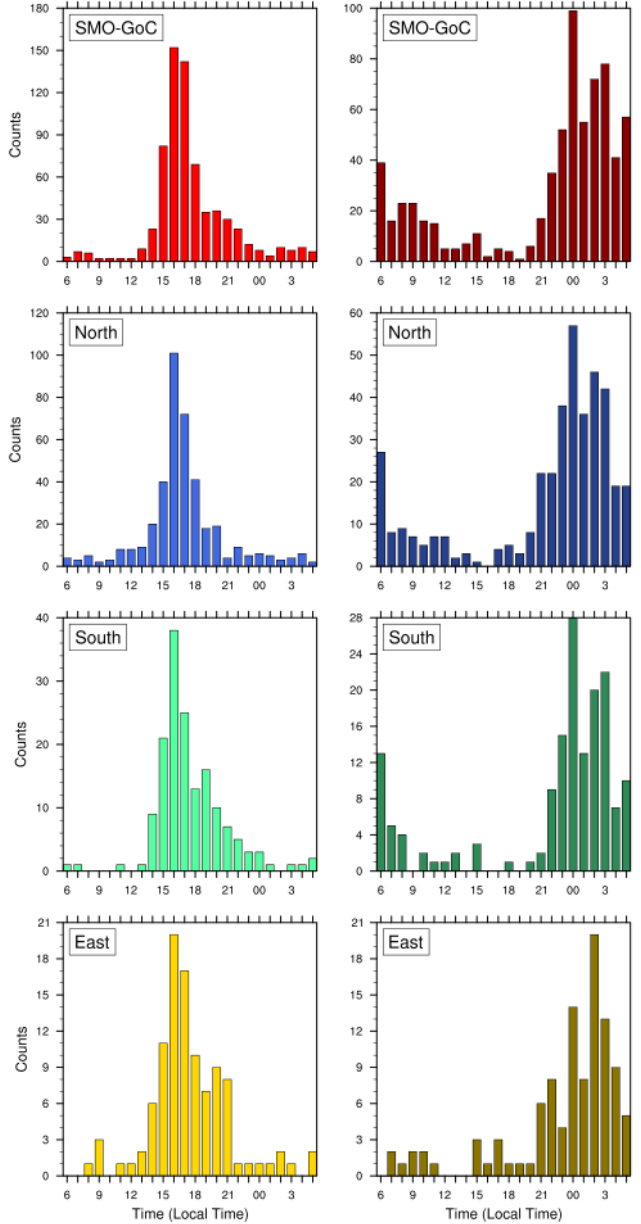
Figure 7. Diurnal cycle counts of MCS initialization time ( left column) and dissipation time ( right column) at LT (UTC-6). MCS propagating towards the GoC, in a northerly direction, and in a southerly direction, and traveling towards Chihuahua correspond to the upper, middle and bottom panels,